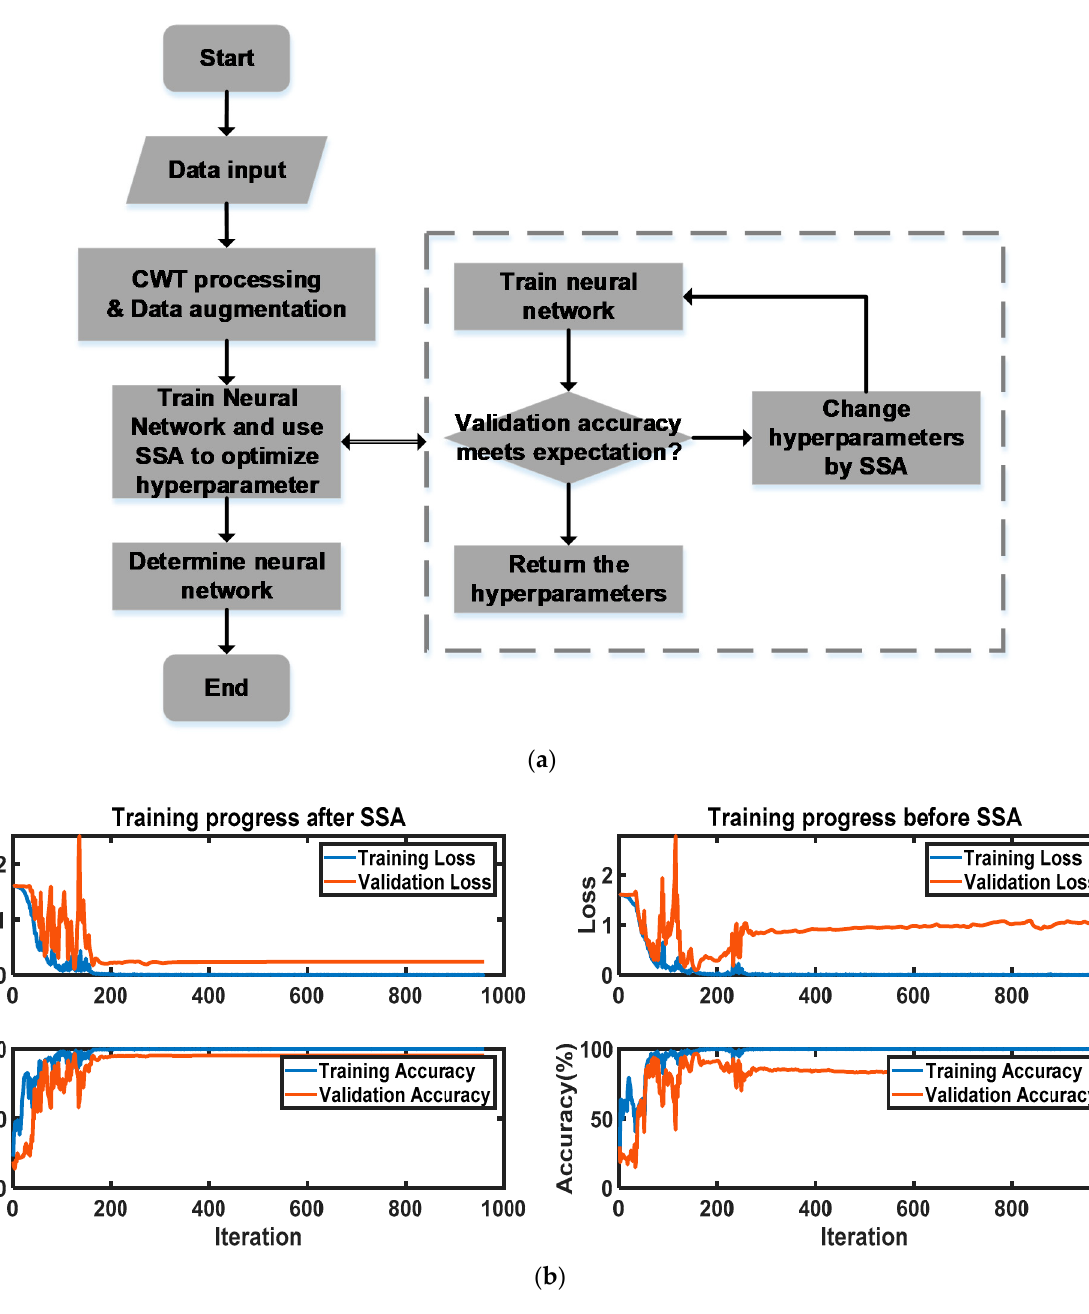
Figure 4. The deep learning method: ( a ) the progress of the whole deep learning algorithm with SSA; ( b ) the training progress comparison.